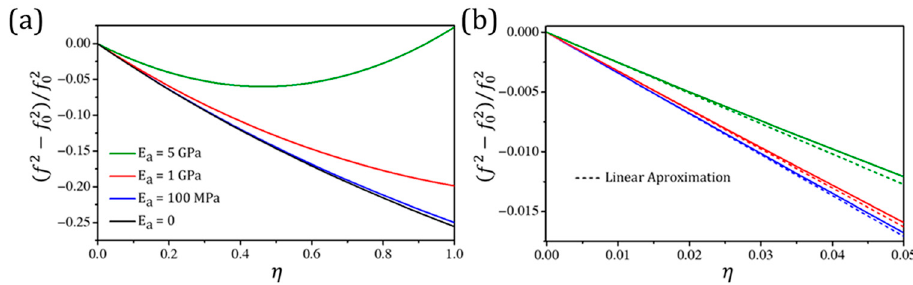
Figure 4. ( a ) Influence of the adsorbed layer on the flexural modes of a silicon beam as a function of the ratio between thicknesses η and for different values of the Young’s modulus of the adsorbed material. ( b ) Same graph, but at the range of values of η where the linear approximation (21) can be applied.